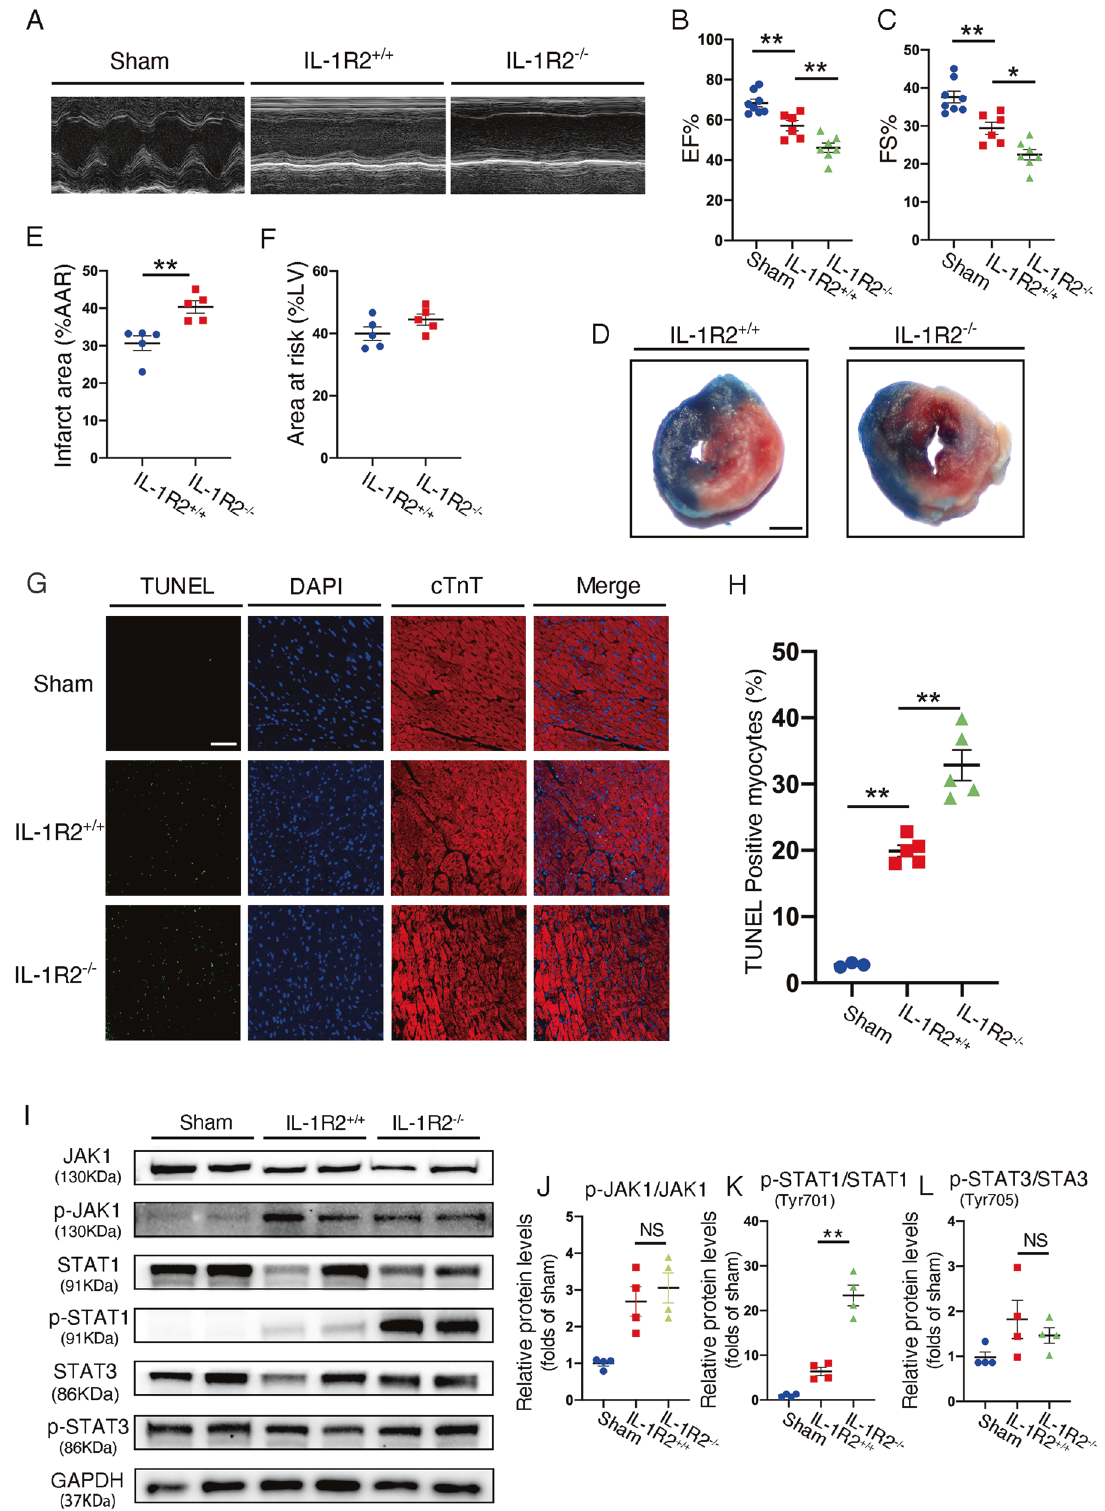
Fig. 3 IL-1R2 knockout mice exacerbated cardiac damage in myocardial I/R injury. A – C Representative echocardiographic images and quanti fi cation for Sham ( n = 8), IL-1R2 + / + ( n = 6) and IL-1R2 − / − ( n = 7) mice subjected to myocardial I/R surgery. D – F Representative images of 2,3,5-triphenyltetrazolium chloride staining in mice subjected to myocardial I/R surgery and quanti fi cation of the relative ratios of infarct area to area at risk (border zone) as well as the relative ratios of the area at risk to left ventricle area in IL-1R2 + / + ( n = 5) and IL-1R2 − / − ( n = 5) mice. Scale bar: 1 mm. G, H Representative images and quantitation of TUNEL staining on the heart sections from the Sham ( n = 3), IL-1R2 + / + ( n = 5), and IL-1R2 − / − ( n = 5) mice. Scale bar: 100 µm. ( I – L ) Representative western blots and quanti fi cation of JAK1, p-JAK1, STAT1, p-STAT1, STAT3, and p-STAT3 in the heart from the Sham, IL-1R2 + / + , and IL-1R2 − / − mice subjected to myocardial I/R surgery. Scale bar: 100 µm. * P < 0.05 and ** P < 0.01. Two-tailed unpaired Student ’ s t -test for two groups or one-way ANOVA for three groups or more. Cell Death and Disease (2022)